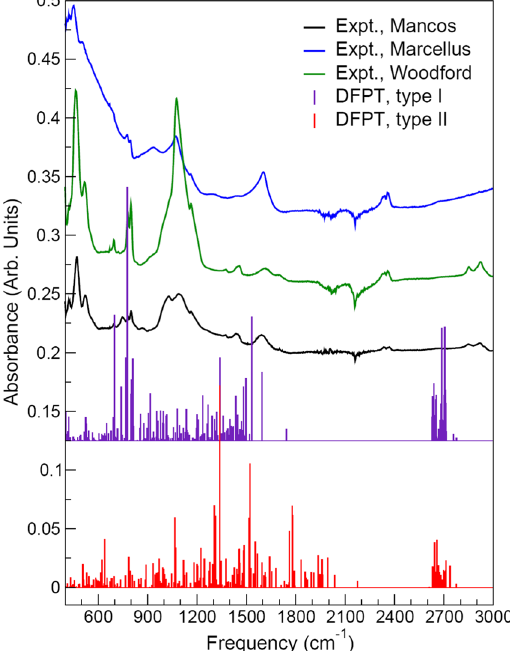
Figure 2. Infrared spectra simulated from density functional perturbation theory (DFPT) at the GGA/PBE level for the type-I and type-II models shown in Fig. 1 and Fourier transform infrared spectra collected for Mancos, Marcellus and Woodford kerogen